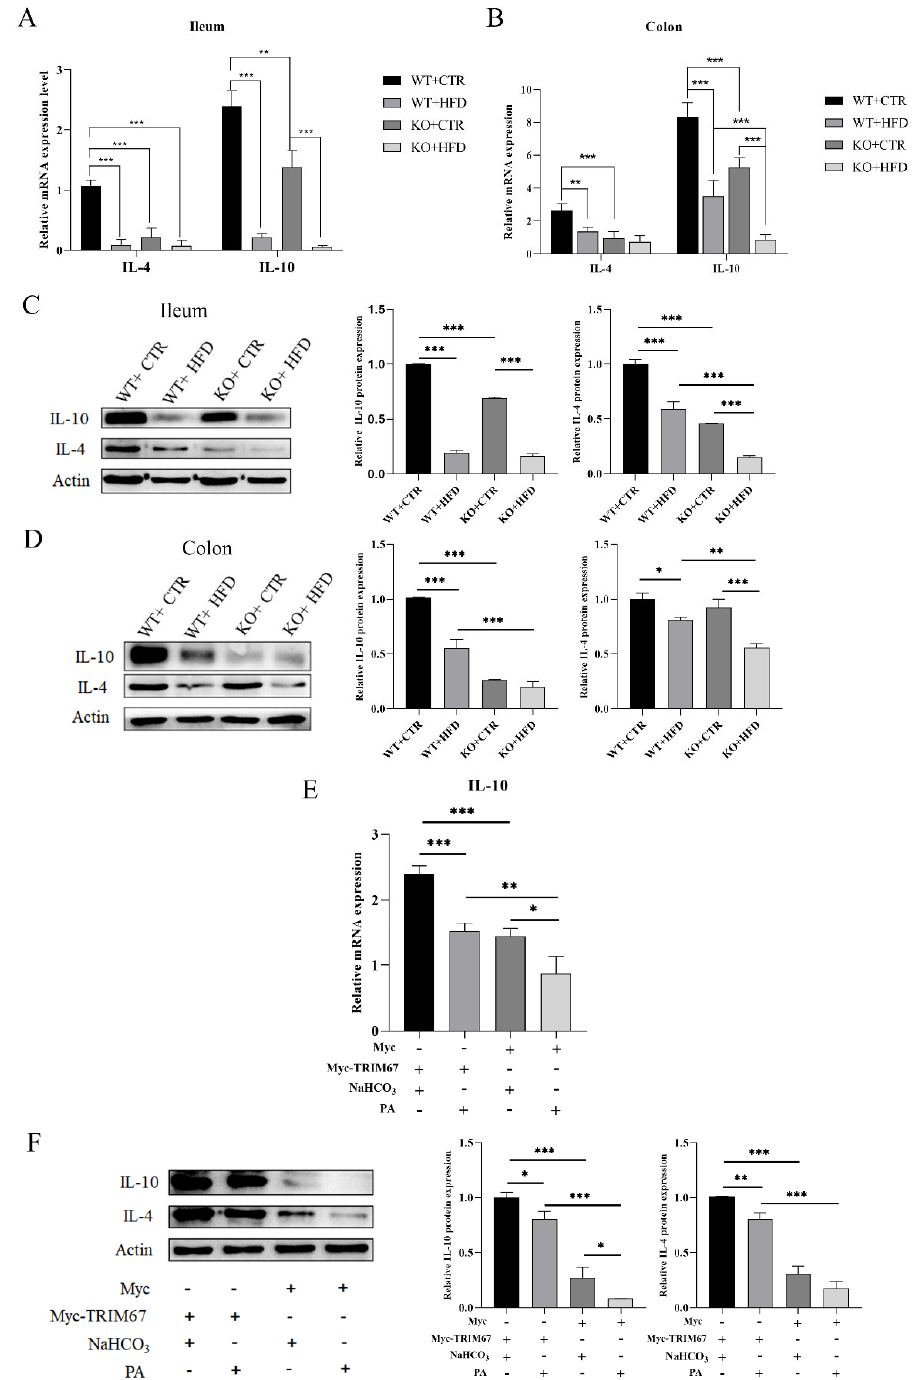
Figure 6. TRIM67 knockout mice display the lower expression of anti-inflammatory cytokines and HFD feeding exacerbates the condition. ( A , B ) Relative mRNA expression of anti-inflammatory cytokines IL-4 ( n = 4) and IL-10 ( n = 5) in ileum and colon. ( C , D ) Western blots and quantification show protein level of IL-4 and IL-10 in ileum and colon ( n = 3). ( E ) Relative mRNA expression show expression of IL-10 in Myc-TRIM67 and Myc group supplemented with NaHCO 3 and PA, “-”: no addition, “+”: addition ( n = 4) ( F ) Western blots and quantification of IL-10 and IL-4 proteins in cell lines, “ ‐ ”: no addition, “+”: addition ( n = 3). The data are expressed as mean ± SEM. Significance was determined by one ‐ way ANOVA (* p < 0.05, ** p < 0.01, *** p < 0.001).